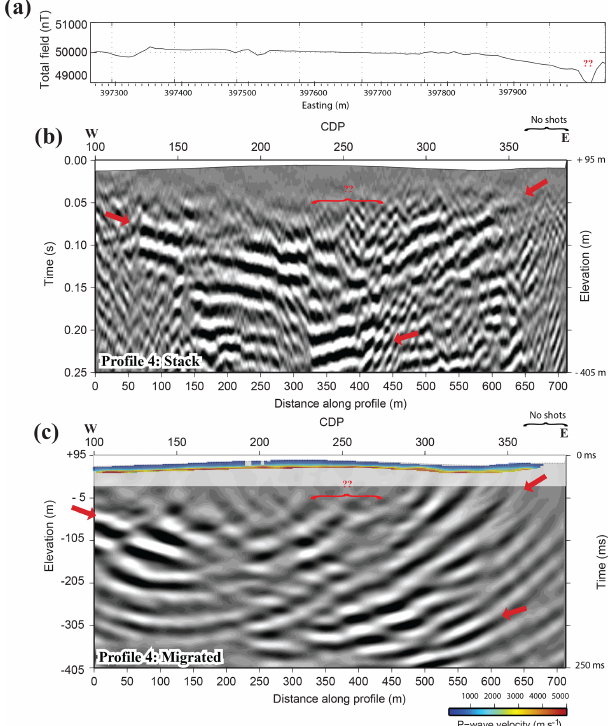
Figure 12. (a) Ground total-field magnetic, (b) unmigrated and (c) migrated (also time-to-depth-converted) reflection seismic sec- tion of profile 4. The tomographic velocity model is projected onto the migrated section for direct comparison. Red arrows mark the re- flections that appear to be divergent and in the middle of the profile more horizontal. The central part of the profile shows indications of down faulting.